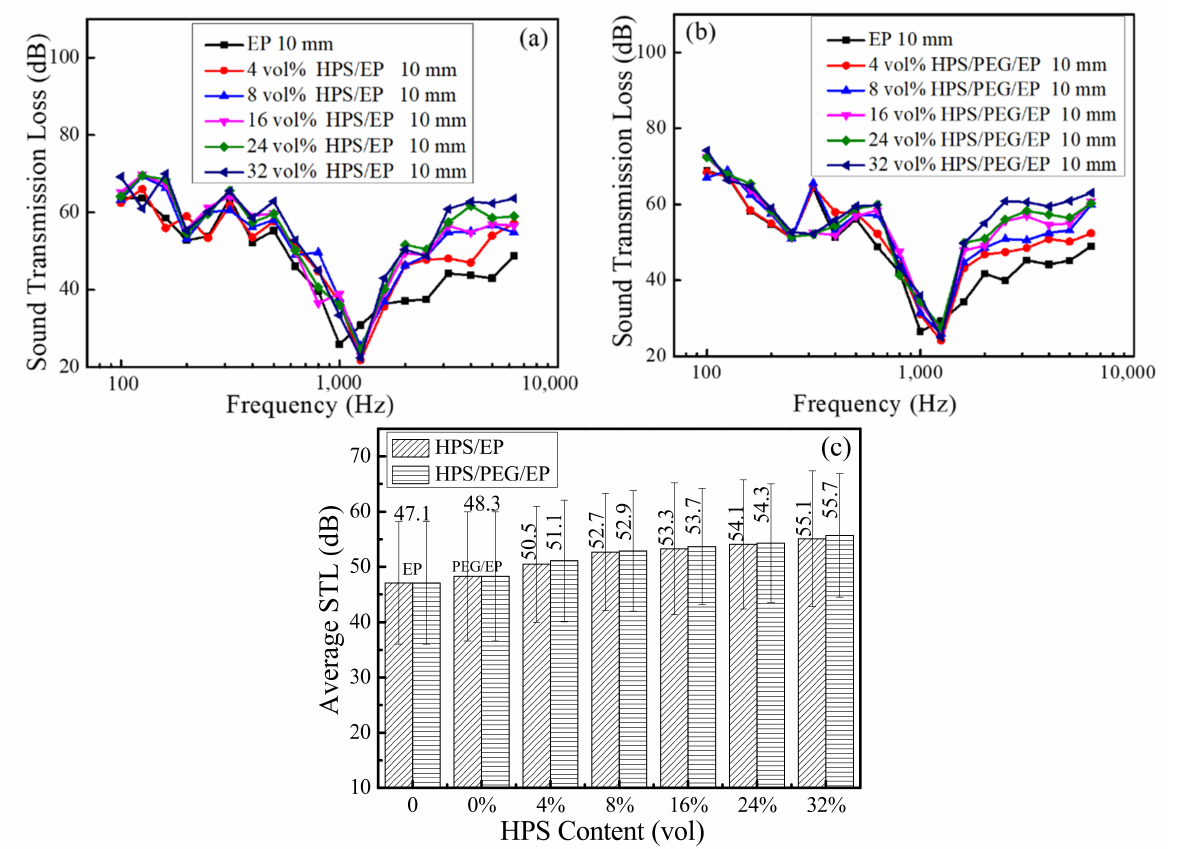
Figure 8. ( a ) Soundproof properties of the EP and the HPS/EP composites with different content of the HPS; ( b ) soundproof properties of the EP and the HPS/PEG/EP composites with different content of the HPS; ( c ) the average STL of the EP, HPS/PEG/EP, and the HPS/PEG/EP composites with different content of the